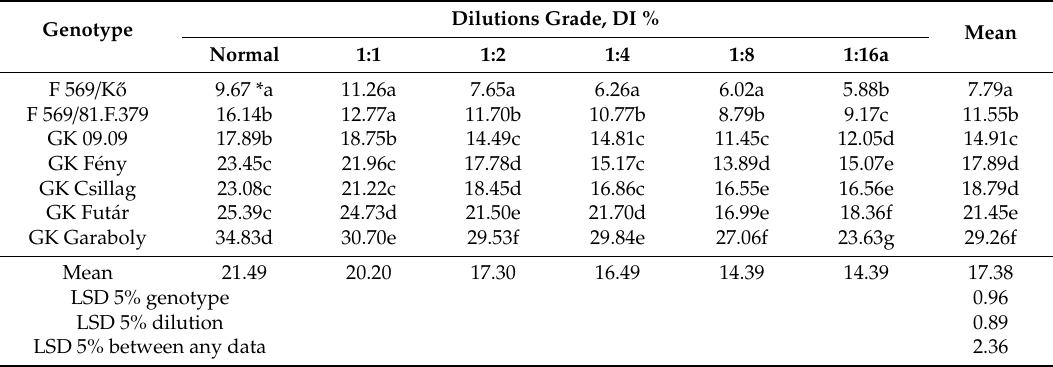
Table 4. Reduction of the aggressiveness of the winter wheat genotypes at di ff erent dilutions acr5oss isolates, visual screening data (Disease Index %) in